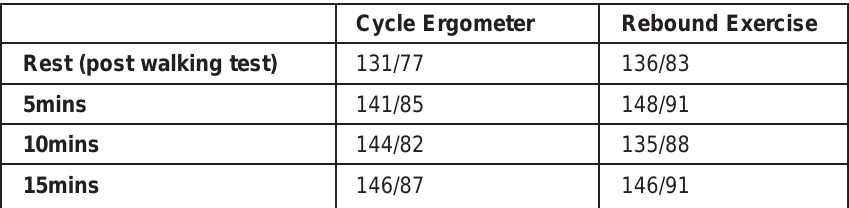
Table 3: Blood Pressure recordings